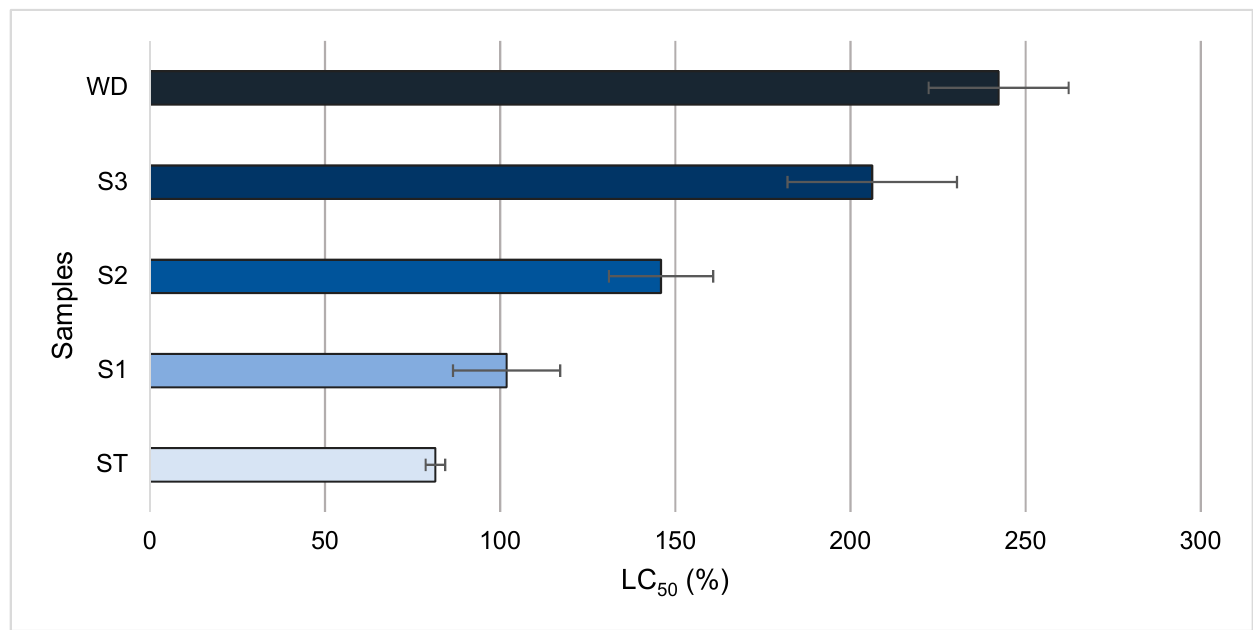
Figure 2. Lethal concentration (LC 50 ) in Artemia sp . for different assessed samples (n = 5). Abbreviations: wastewater without diclofenac (WD); post-septic tank domestic wastewater with diclofenac (ST); post-septic tank domestic wastewater with diclofenac, treated with solar radiation for 1 h (S1), 2 h (S2), and 3 h (S3).